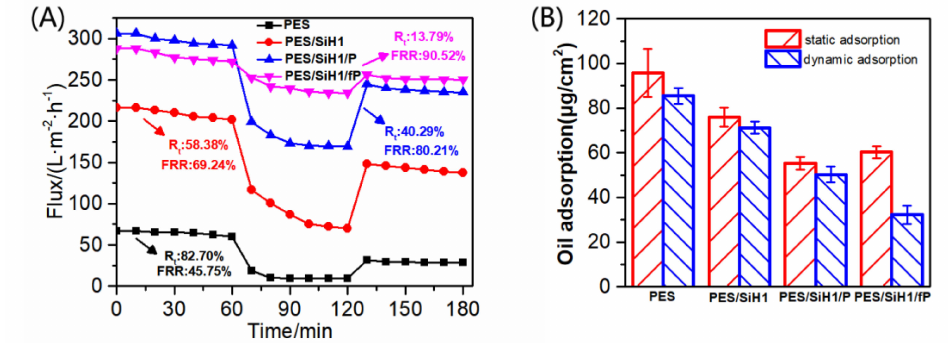
Figure 8. ( A ) The time-dependent fluxes of the tested membranes during the oil-in-water emulsion filtration; ( B ) the oil adsorption onto the PES, PES/SiH1, PES/SiH1/P, and PES/SiH1/fP membranes under unstirred and stirred (200 rpm)